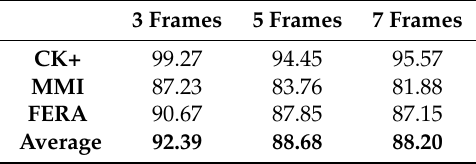
Table 3. The recognition accuracy according to three different input data structures